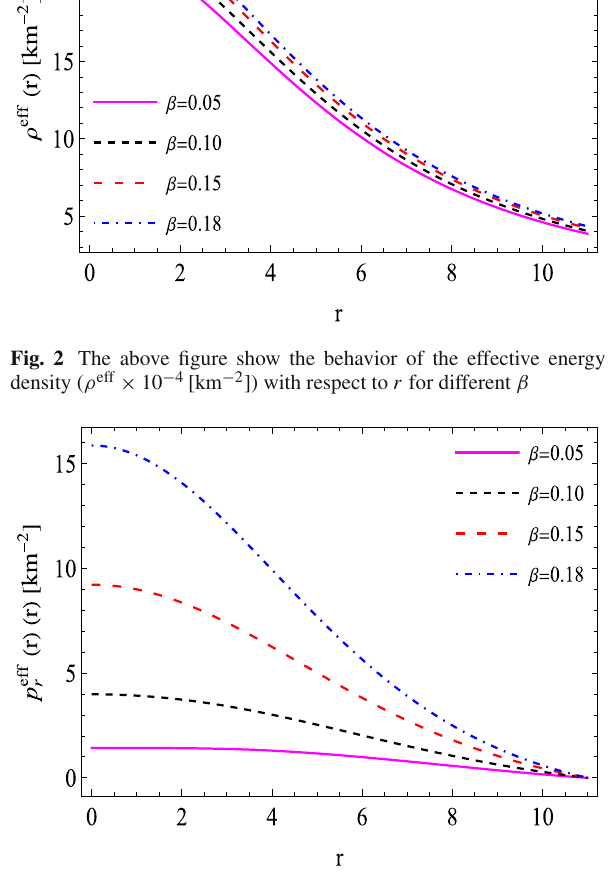
Fig. 3 The above figure show the behavior of the effective radial pres- sure ( p eff r × 10 − 4 [ km − 2 ] ) with respect to r for different